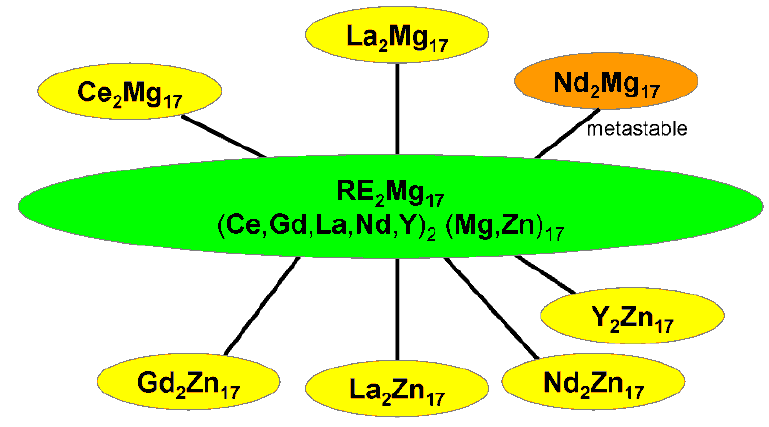
Figure 8. Sketch of the unified model of the multicomponent phase RE its connection to all stable binary phases and the metastable end member phase Nd Mg 2 17